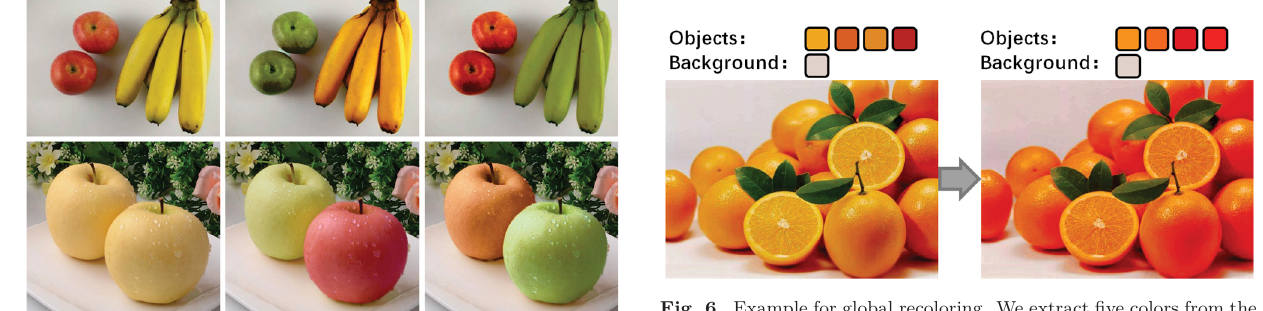
Fig. 6 Example for global recoloring. We extract five colors from the objects and a color from the background. The five colors of the objects are transferred while the colors of the background are preserved.